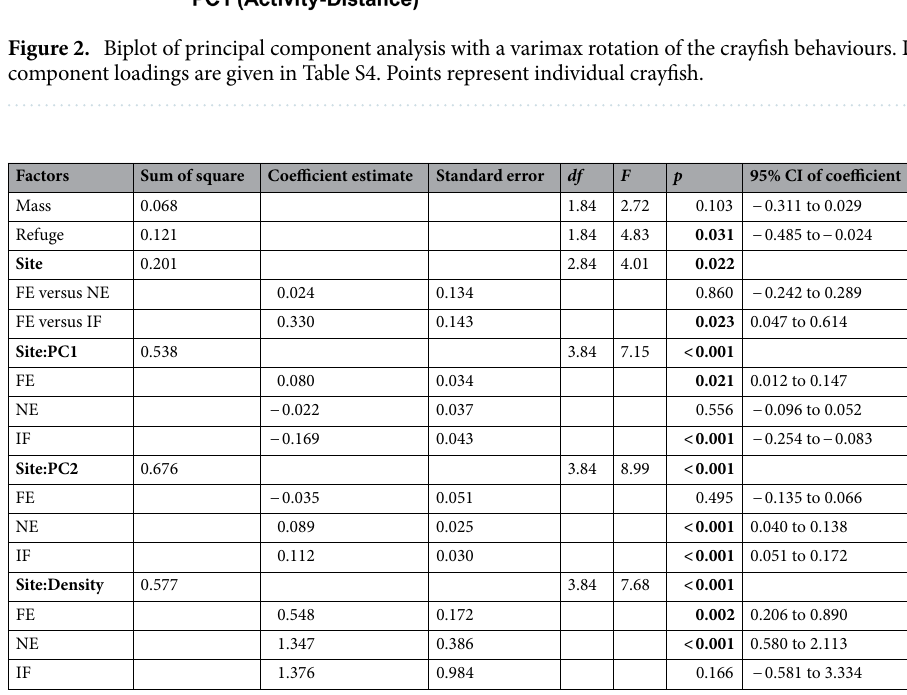
Table 5. Final model of factors affecting signal crayfish dispersal rate in relation to personality traits (PC1, Activity-Distance; PC2, Boldness-Exploration-Climbing), population density and refuge availability, obtained by averaging of the top four models shown in Table S3. Significant values are in bold. Sites: FE fully-established, NE newly-established, IF invasion